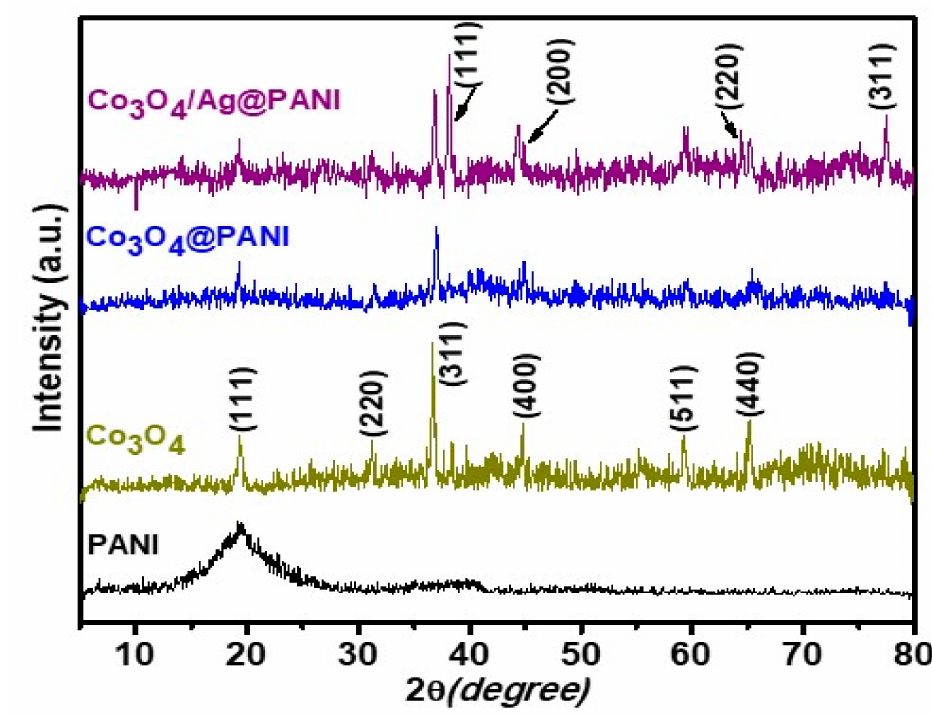
Figure 5. XRD pattern of PANI, Co 3 O 4 , Co 3 O 4 @PANI binary and Ag / Co 3 O 4 @PANI ternary nanocomposites scanned in the 2 θ range of 5–80 ◦